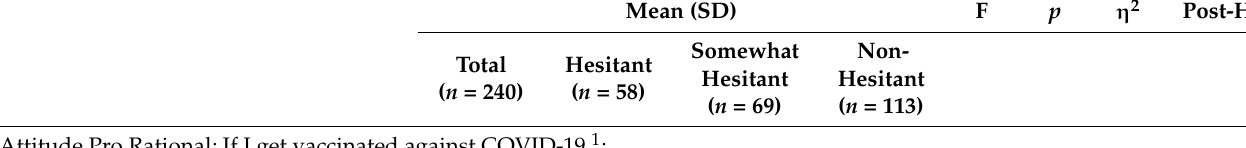
Table 4. Between-Group Variance Analyses for Motivational Factors and Intention. Mean (SD) F p η 2 Post-Hoc Non- Somewhat Total Hesitant Hesitant Hesitant ( n = 240) ( n = 58) ( n = ( n = 69)